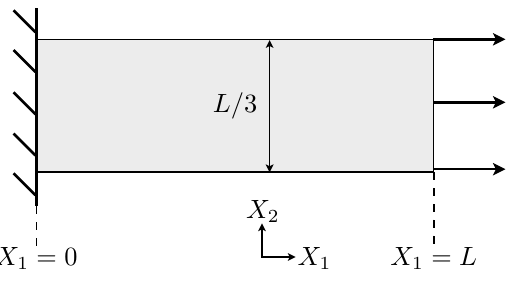
Figure 3 . Geometry and boundary conditions of a two-dimensional bar fixed at X 1 = 0 and subject to an applied traction at X 1 = L .